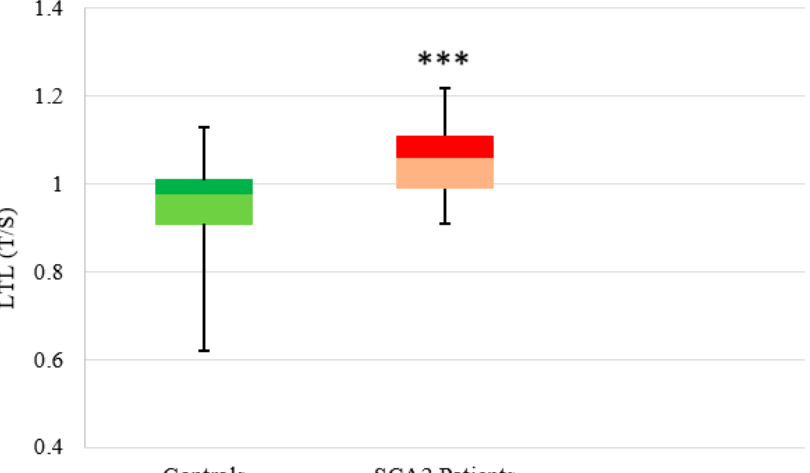
Figure 3. Distribution of LTL in controls and SCA2 patients. Box plot showing the distribution of LTL (T/S ratio) (the number of copies of telomeric repeats T compared to a single copy gene S) used as a quantitative measure in controls (n = 52) (median: 0.98, Q1: 0.91, Q3: 1.01) and SCA2 patients (n = 26) (median: 1.06, Q1: 1, Q3: 1.12) (*** p < 0.001). No difference was observed in mean LTL between males and females in the two groups (controls: p = 0.28, SCA2 patients: p = 0.36).